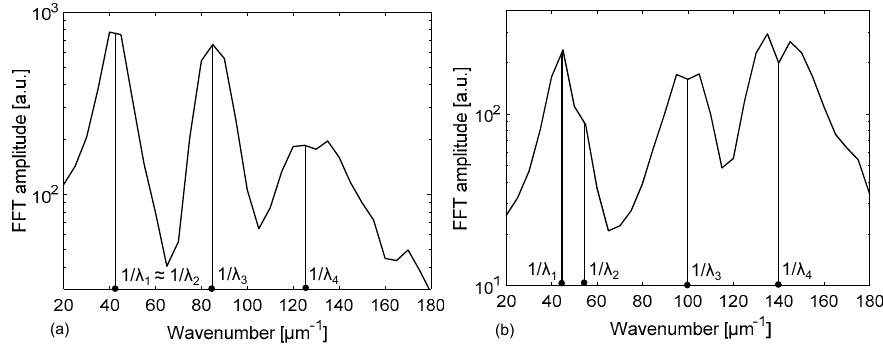
Figure 5. Results of the Fast Fourier Transform applied to the calculated spectral reflectivity reported in Figure 3 for a rectangular–miniature hollow glass tubing with d = 50 µm, t f = t b = 35 µm (nominal dimensions): ( a ) empty channel; ( b ) channel filled with water.